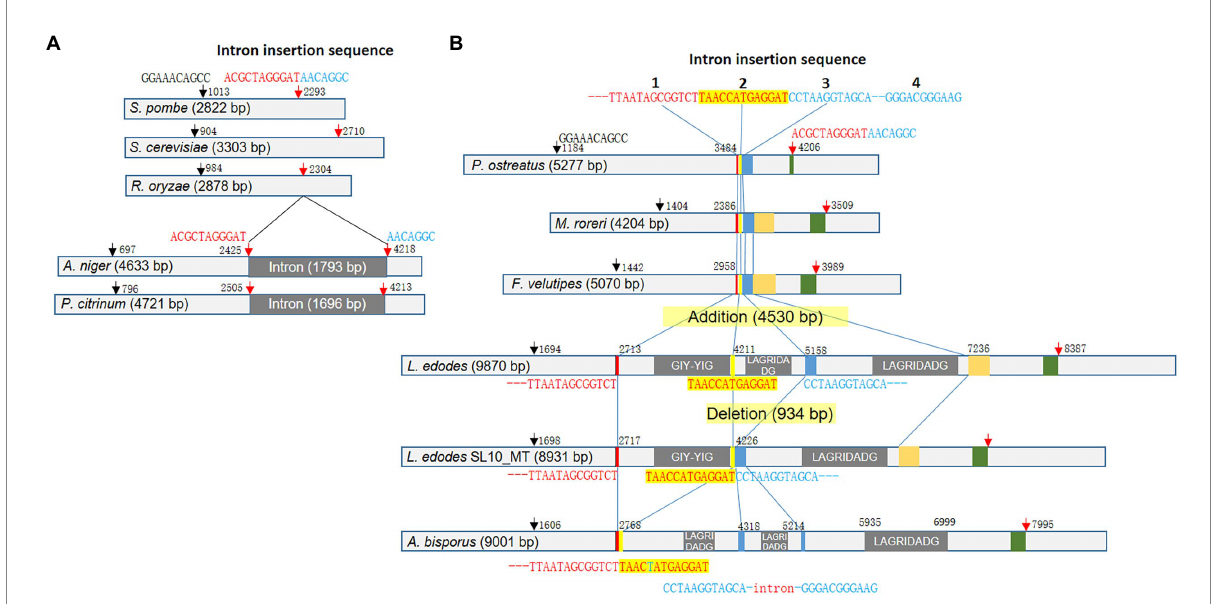
FIGURE 4 Variations of rnl in fungal mtDNAs. (A) Diversification of rnl in ascomycetes. The consensus sequences and the positions are depicted at the top of the gene scheme with arrows. Intron insertion splits the second consensus sequence into two pieces. (B) Diversification of rnl in basidiomycetes by intron insertion. The conserved sequences regions are color-boxed. The consensus sequences found in ascomycetes are also present in basidiomycetes (arrows). rnl in the mtDNA of L. edodes generally contains three introns with intronic HEG gene. However, SL10_MT lacked the second intron, resulting in the direct connection of the second and the third intron insertion sequences. Rnl of A. bisporus mtDNA has a new intron in between the third and the fourth intron insertion